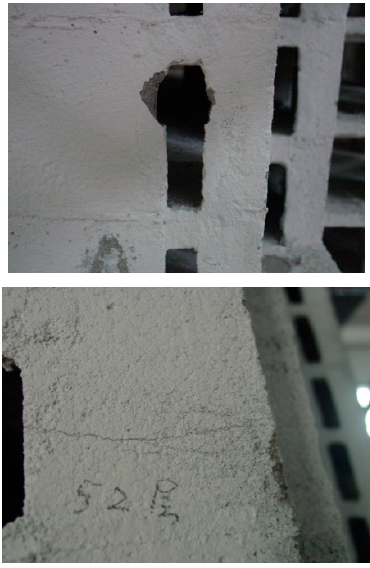
Figure 8. Damage after the test (52nd floor).